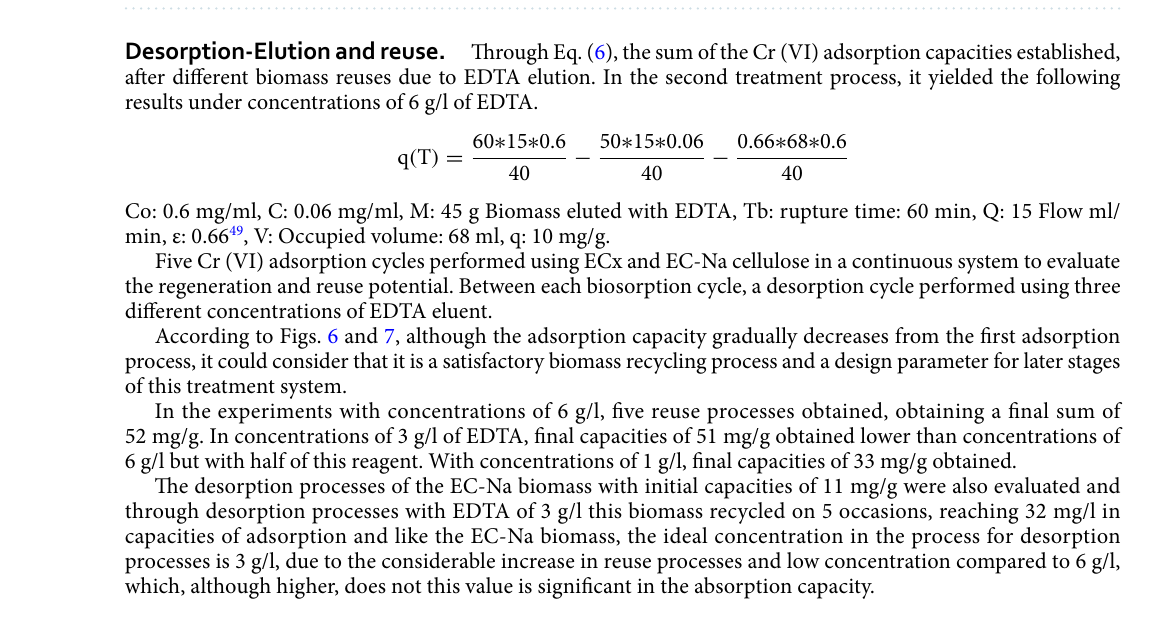
Figure 6. Adsorption capacities in the different adsorption processes in the biomass ECx.